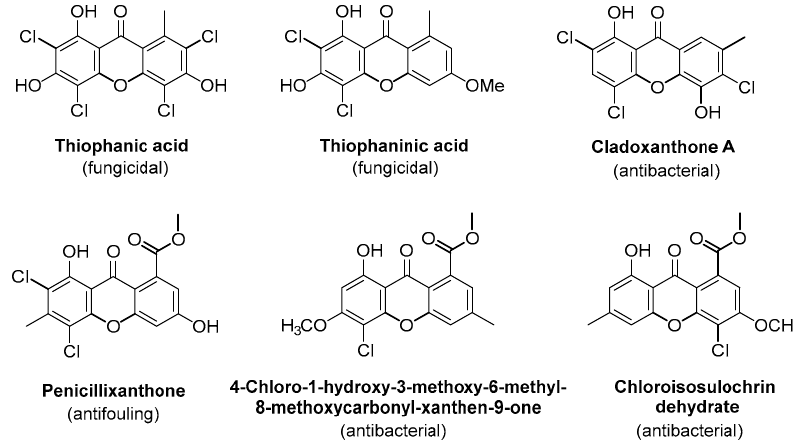
Figure 1. Natural chlorinated xanthones with antimicrobial activities.